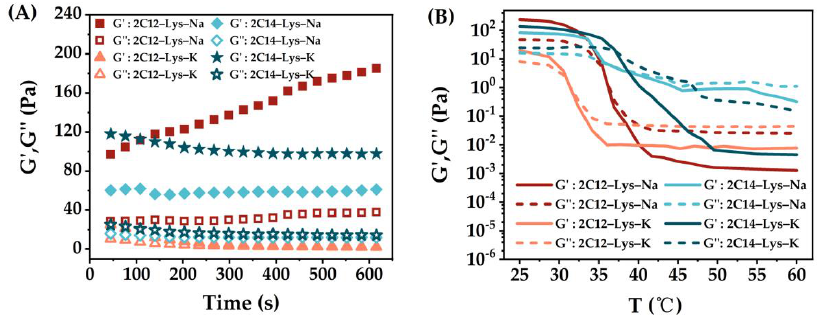
Figure 7. Rheological behaviors of gels formed by 2C12-Lys-Na, 2C12-Lys-K, 2C14-Lys-Na, and 2C14-Lys-K in methanol – water mixtures: ( A ) Variation of storage modulus (G’) and loss modulus (G ″ ) with time; ( B ) dependence of the storage modulus (G’) and loss modulus (G ″ ) with the temper- ature.